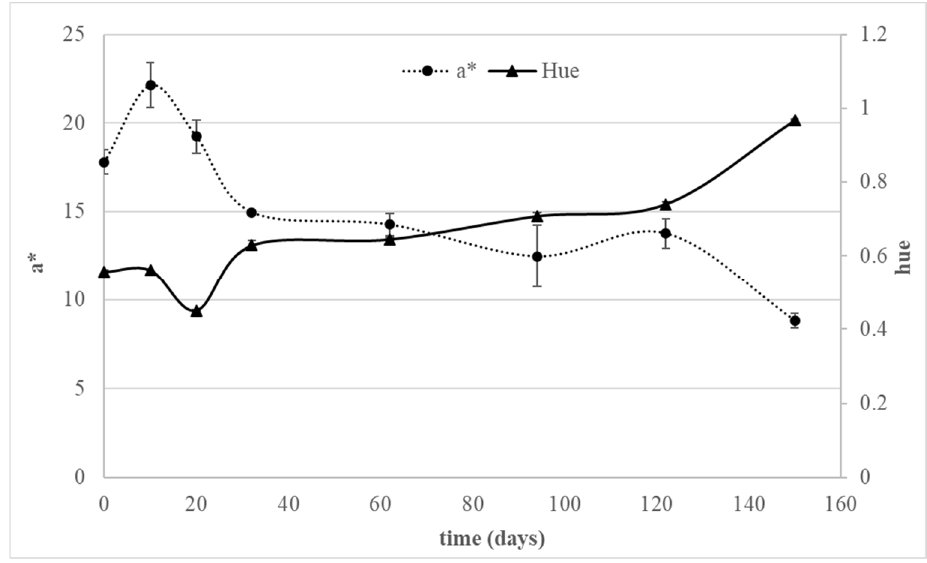
Figure 1. Color parameters (a* and hue) of HPP-treated sour cherries during refrigerated storage.